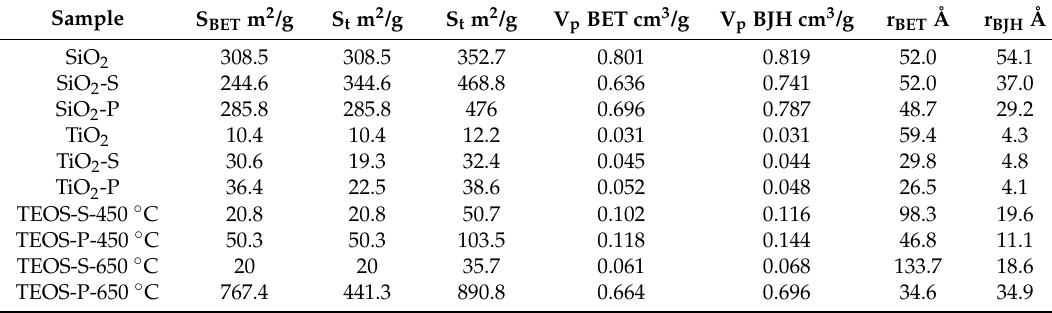
Table 1. Surface areas, total pore volume and average pore radius of solid catalysts determined by